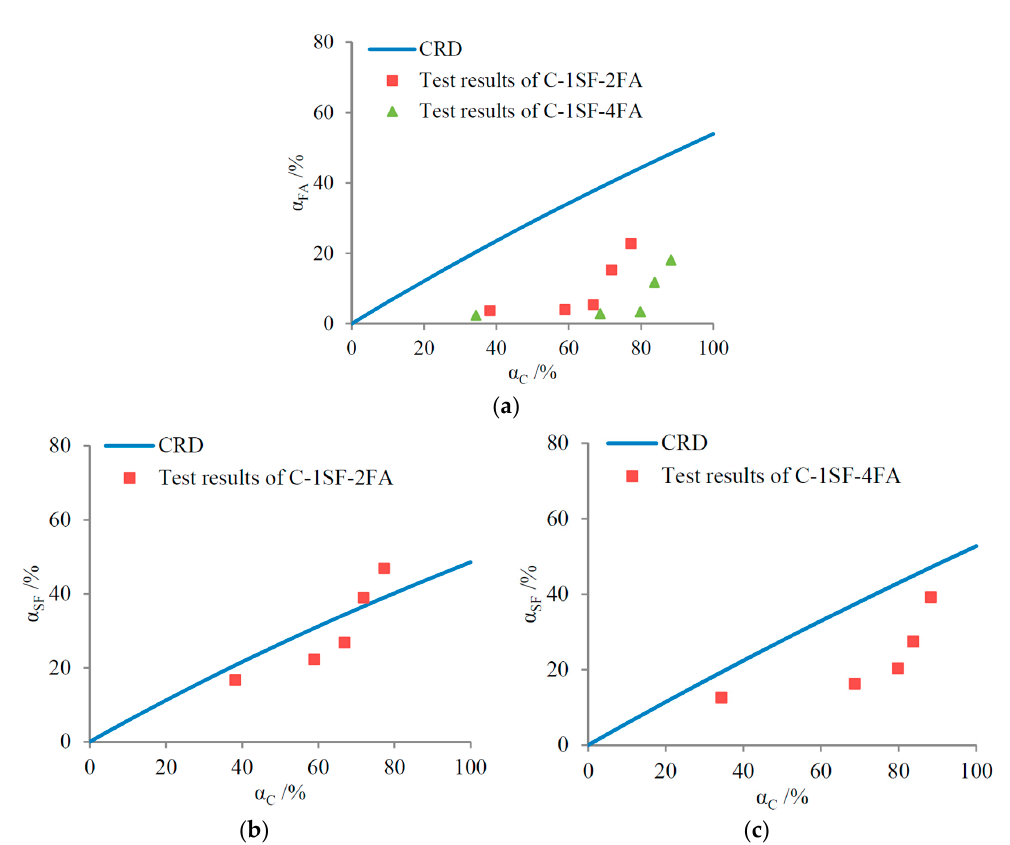
Figure 10. Predictions of effect of SCM replacements in C-SF-FA system: ( a ) FA replacement, when m SF = 10%; ( b ) SF replacement, when m FA = 20%; and ( c ) SF replacement, when m FA =